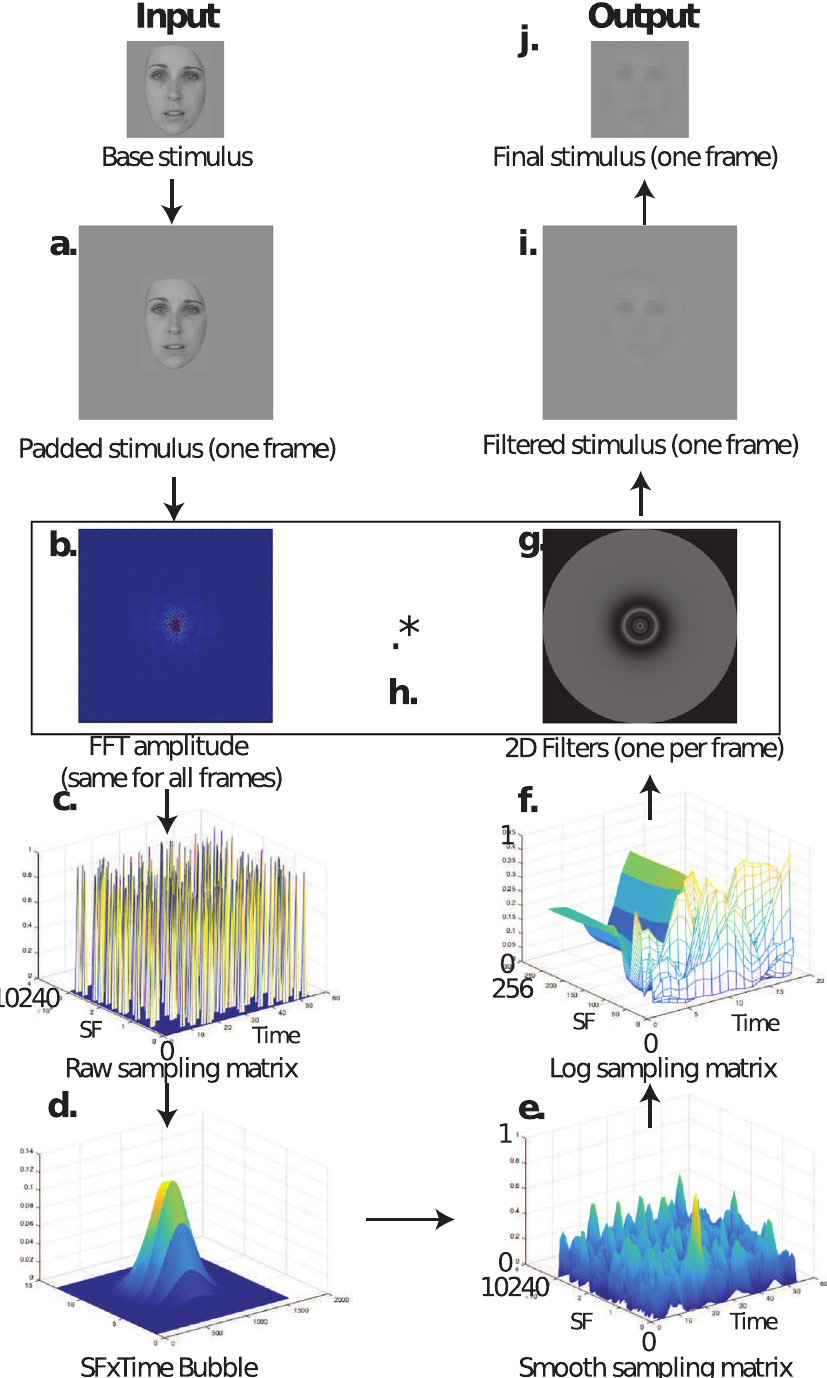
Figure 4. Example of the creation of one stimulus with the temporal SF filtering